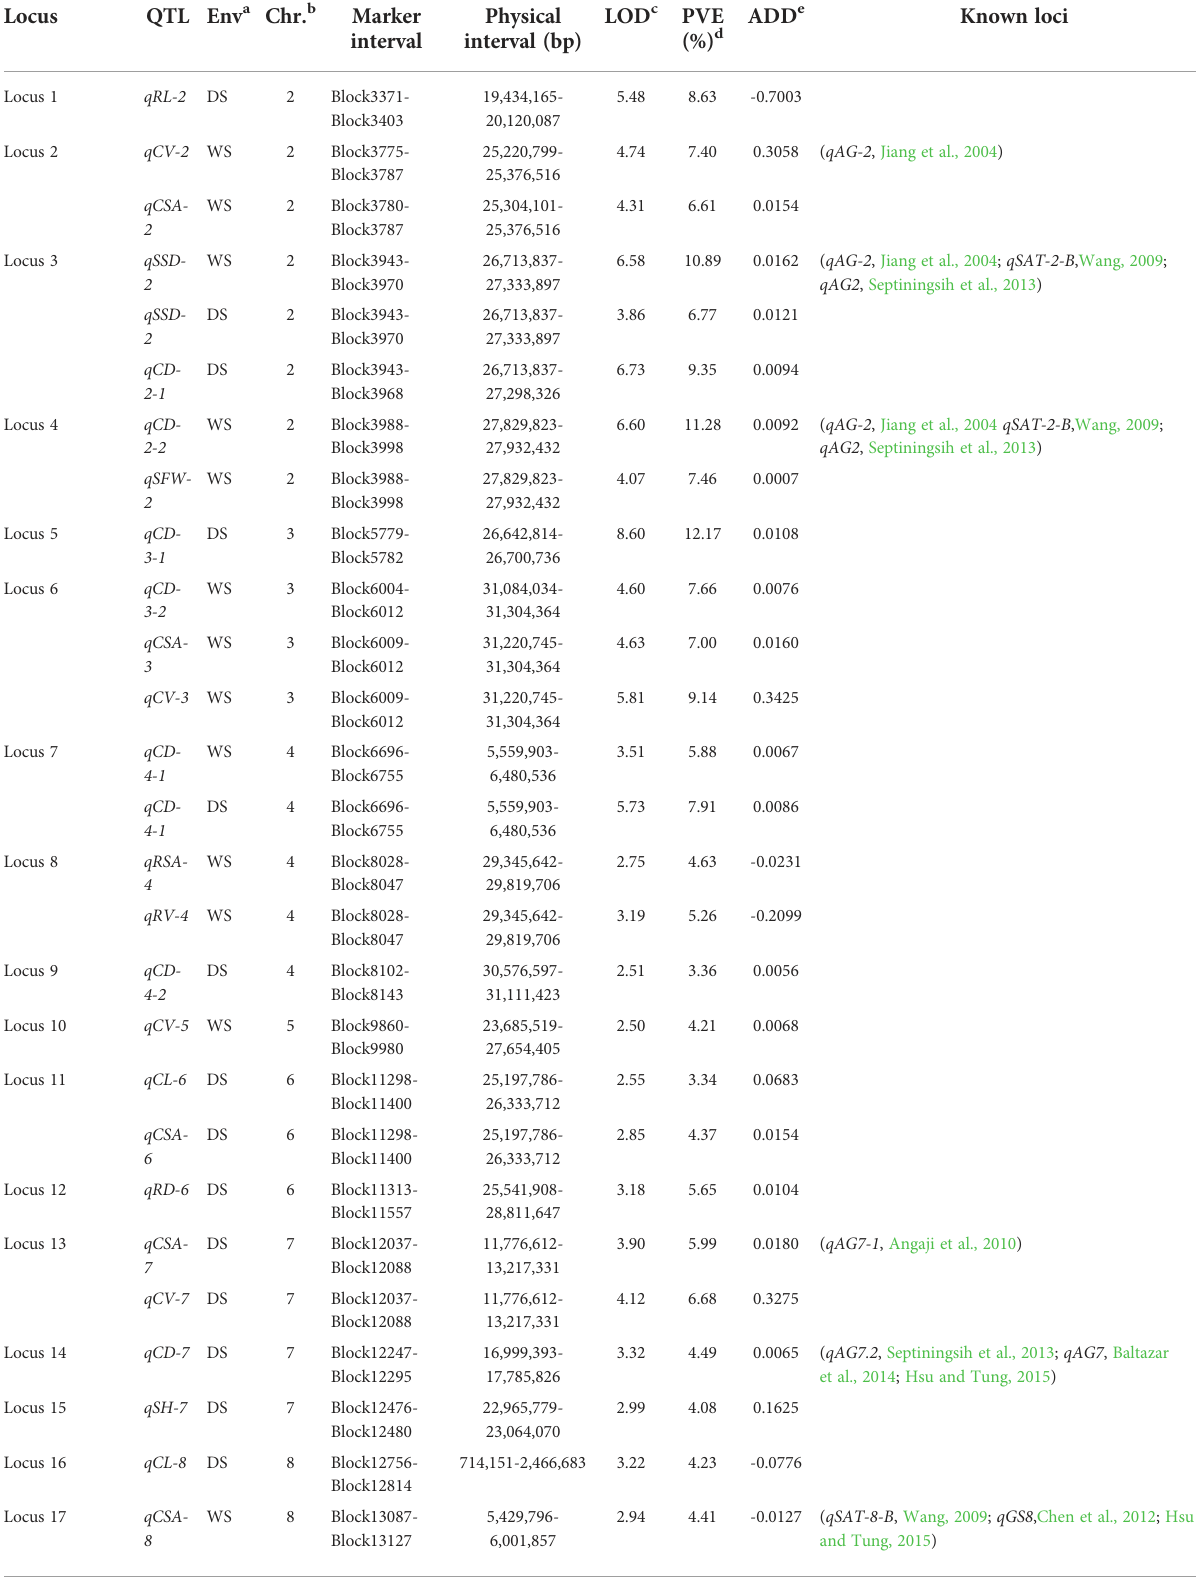
TABLE 3 QTLs that are associated with anaerobic tolerance at the germination and bud stages and that were detected in the RIL population. Locus QTL Env a Chr. b Marker